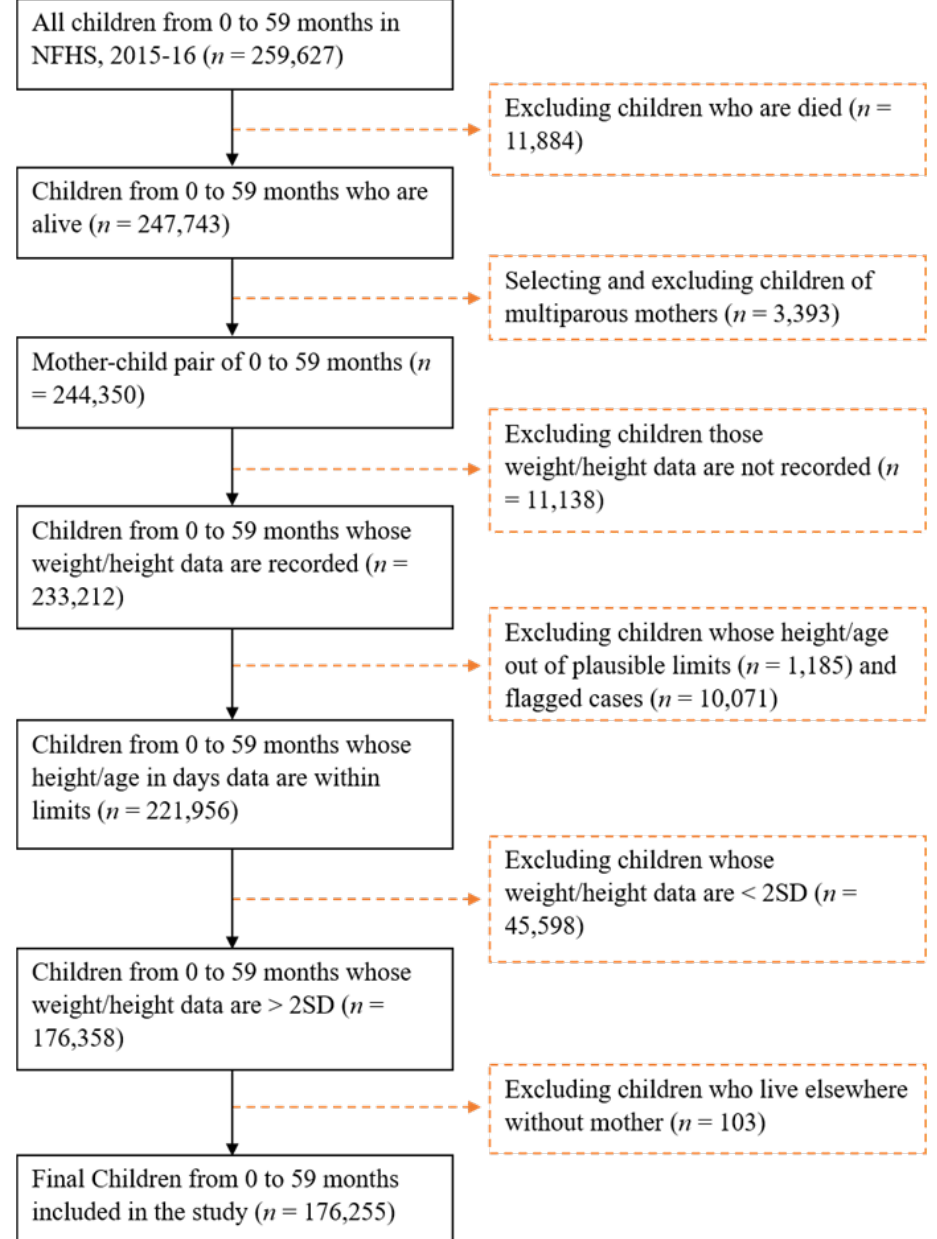
Figure 1. Flow diagram showing children aged 0 to 59 months included in the study for analyses from the 2015–16 NFHS-4, India.